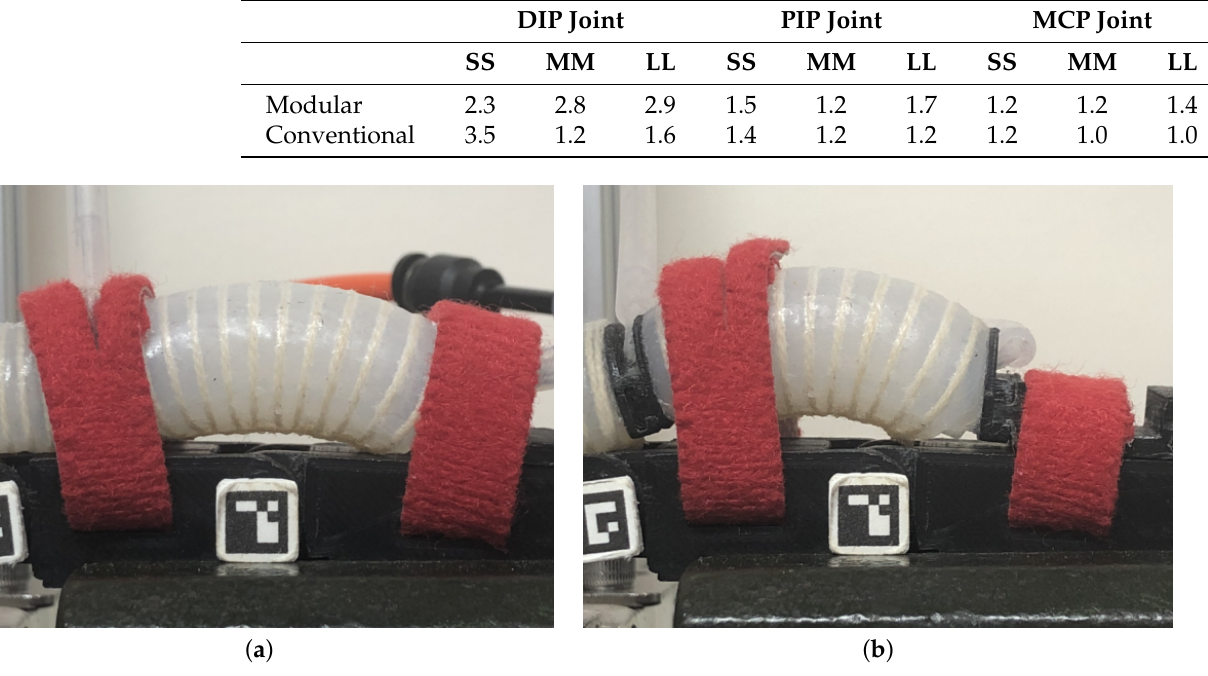
Figure 13. Different chamber deformations for matched and unmatched pairs. ( a ) Matched pair M-M; ( b ) unmatched pair